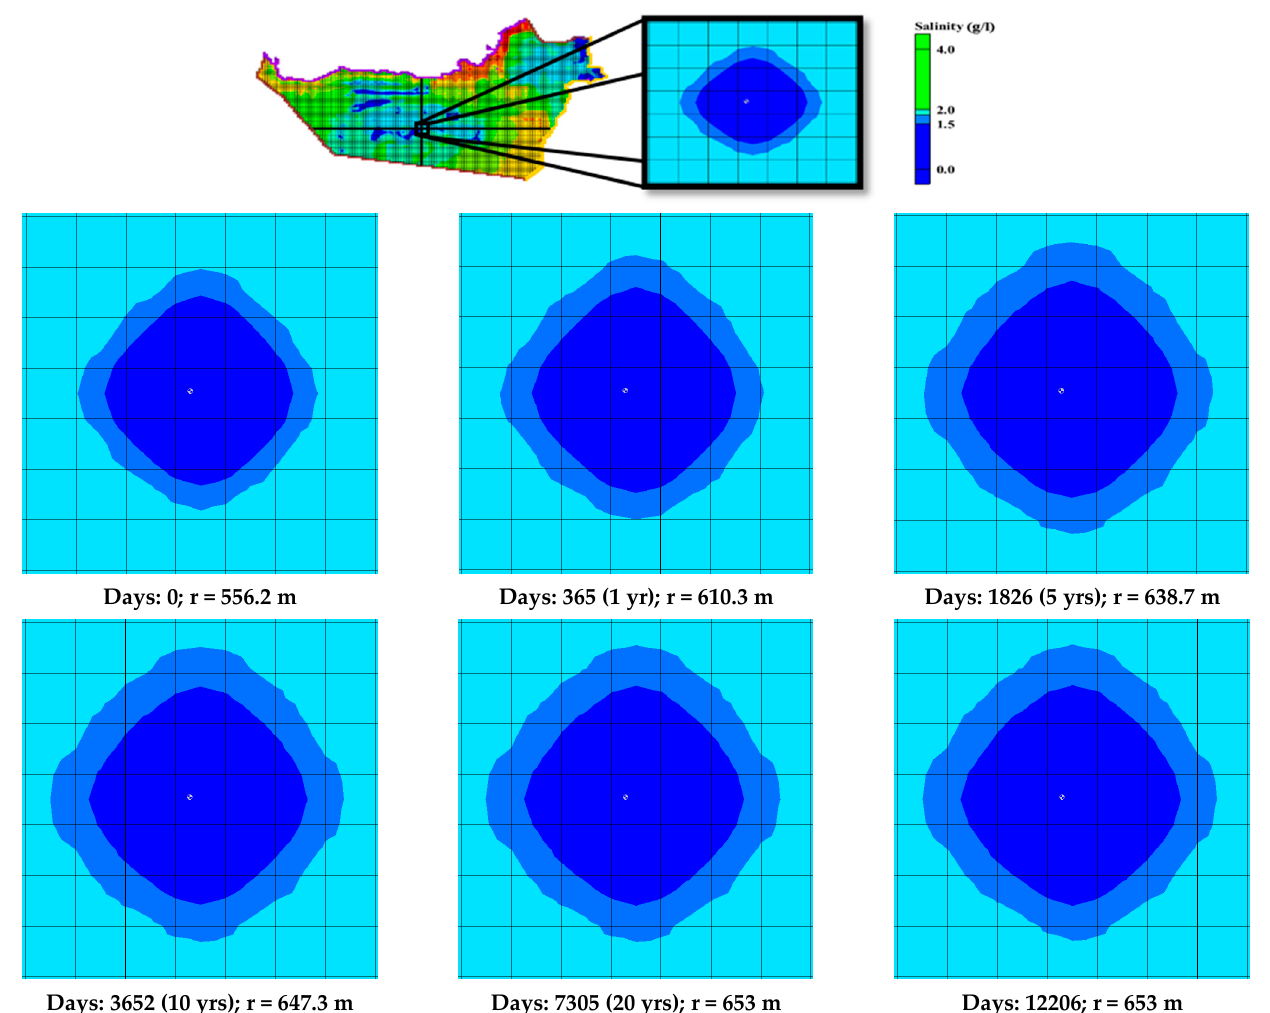
Figure 7. Formation of freshwater lens during the period of recharge and long-term storage.